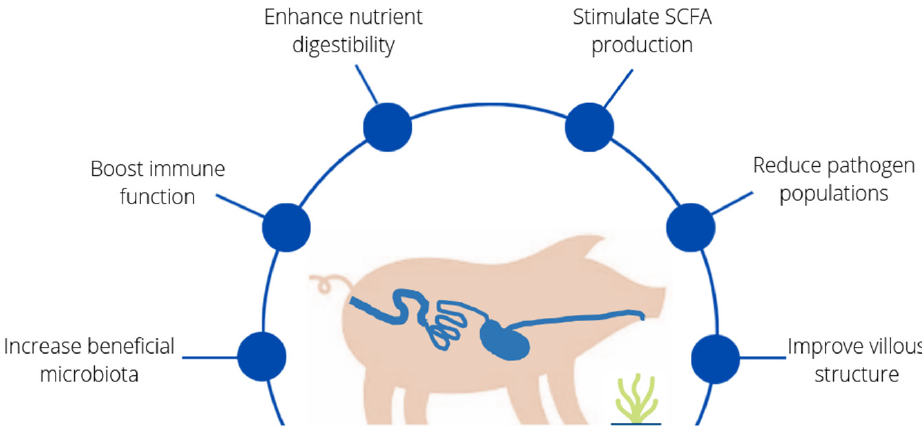
Figure 2. Benefits of seaweeds on piglet gut health. Increase beneficial microbiota [84,85,87,88,92,93,95], boost immune function [85,91,95], enhance nutrient digestibility [84–87,89,96], stimulate SCFA production [91,97], reduce pathogen populations [86–88,92,93,95,97], improve villous structure [87,97].